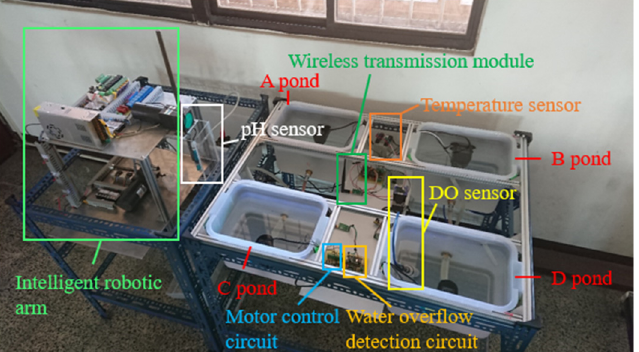
Figure 3. Simulation diagram of intelligent fish farm management system.